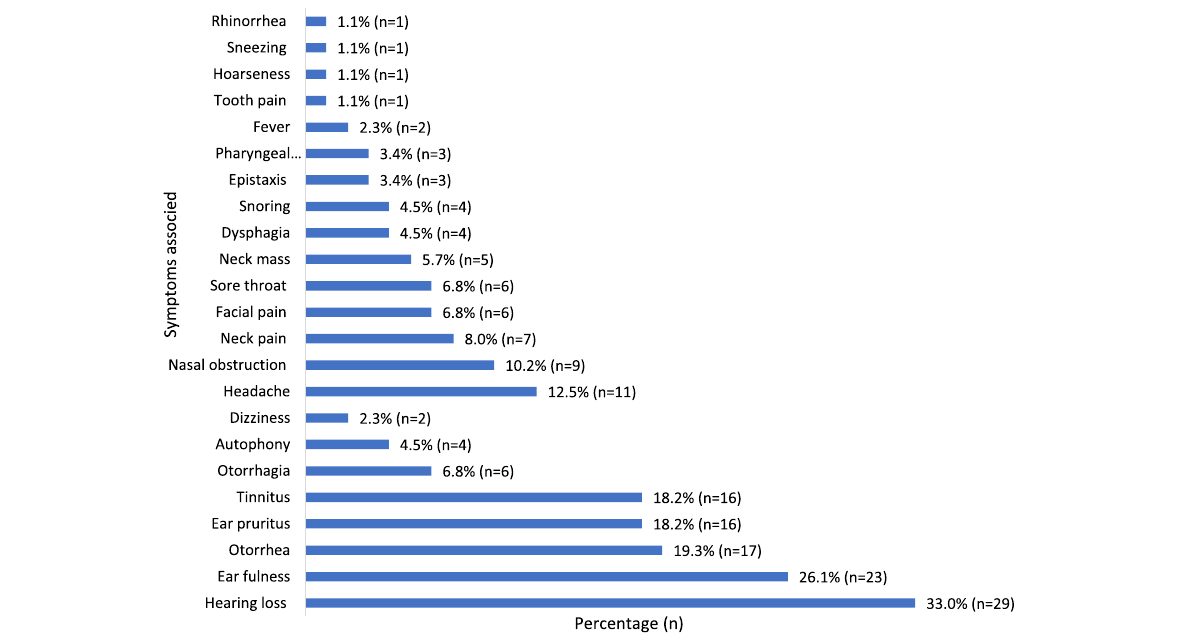
Fig. 1 Frequency of symptoms associated with